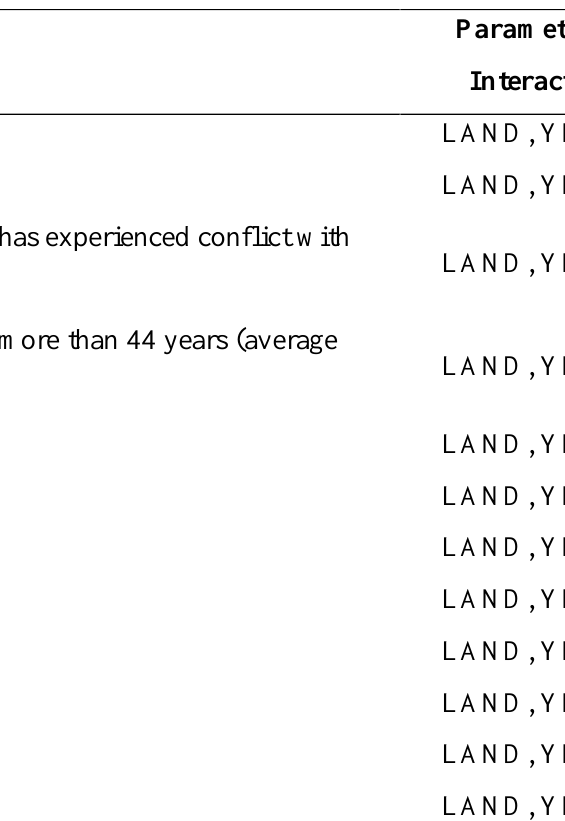
Table A1.1: Description of demographic, economic and socio-psychological variables and the parameters they interacted with in the two RPL